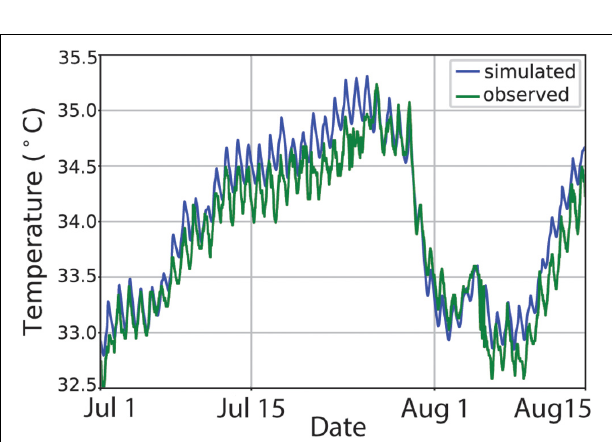
FIGURE 2 | Simulated (blue) vs. observed (green) daily averaged bottom temperature at Saadiyat reef. Vertical lines mark the first day of each year and of each summer month.